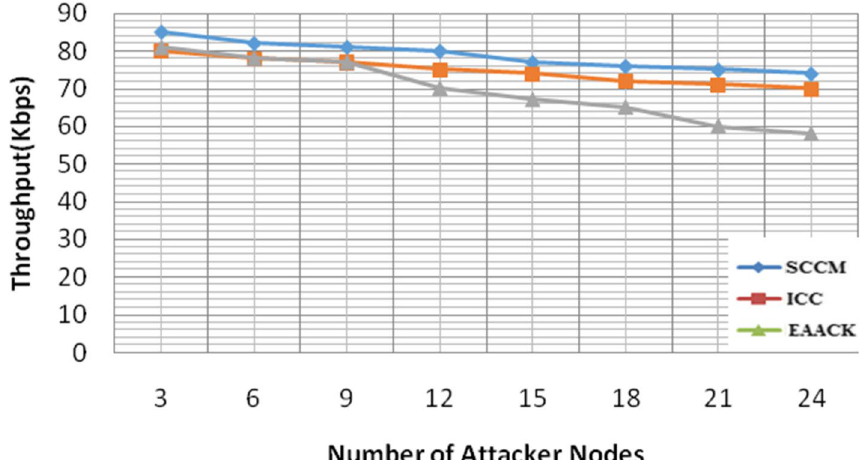
Fig. 14 Throughput vs number of attacker